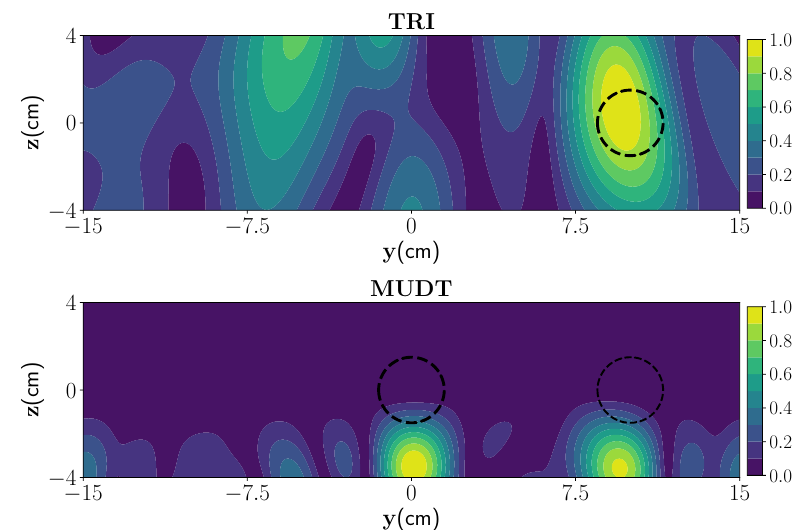
Figure 8. ( Top ) Magnitude of the first four eigenvalues versus the frequencies, ( second row ) re- construction of the first wet spot moisture case with TRI-DORT using first dominant eigenvalue and ( third row ) reconstruction of the second wet spot moisture case with TRI-DORT using second dominant eigenvalue when the layer 2 is a PEC plate, ( fourth row ) reconstruction using MUDT imaging